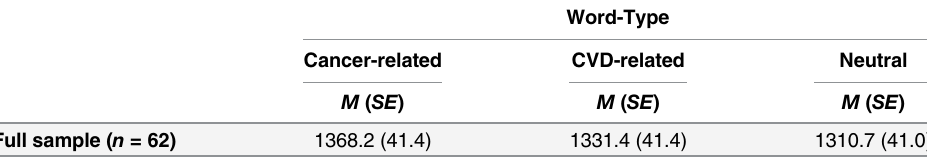
Table 2. Response Latencies in Milliseconds as a Function of Word-Type for the Full